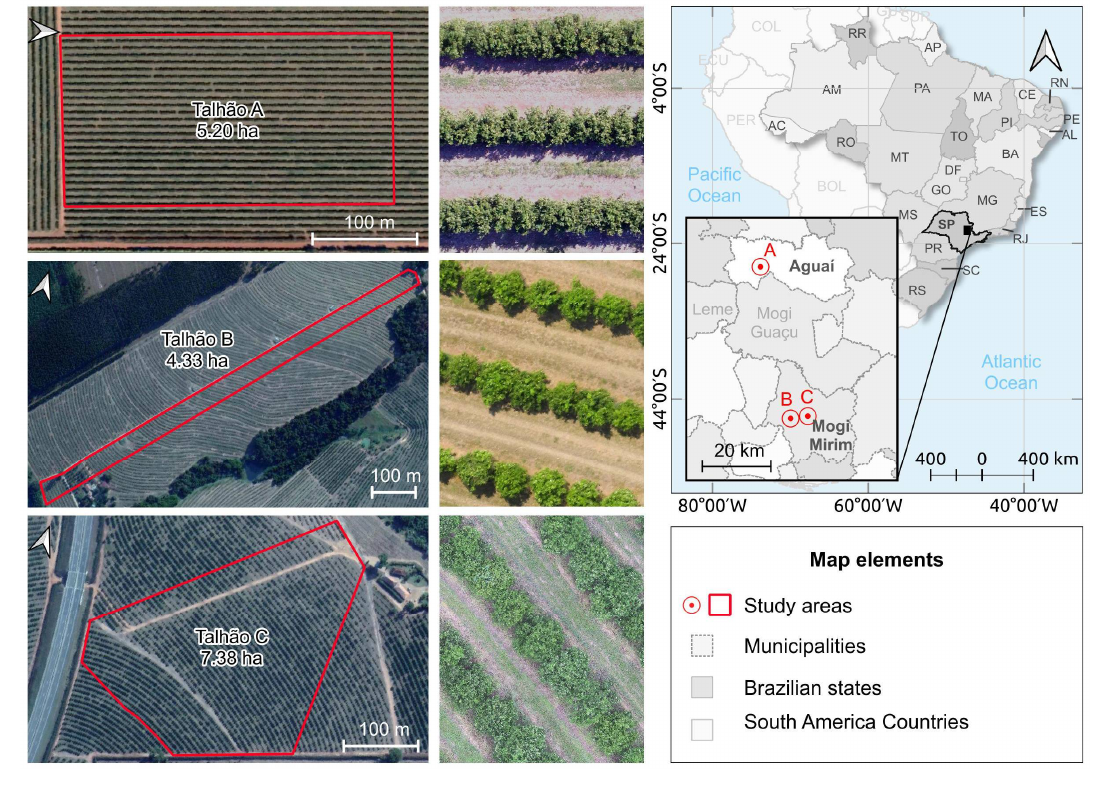
Figure 1. Location map of the study areas and details of the adopted plots.